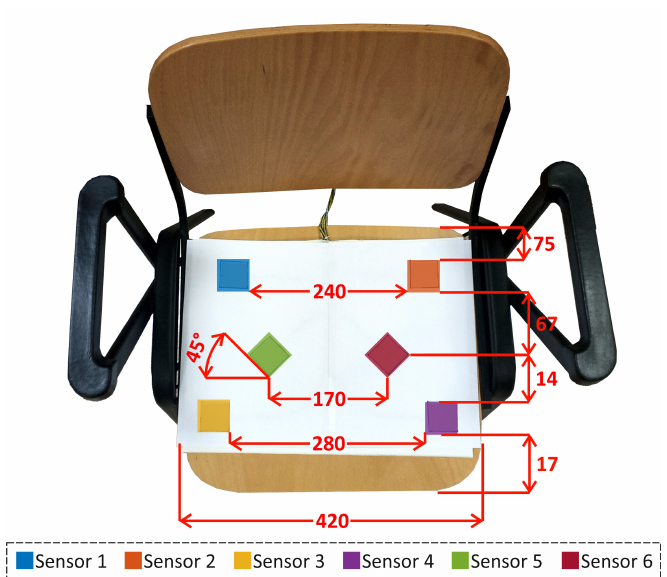
Figure 1. Measuring device installed on a chair. The device has bilateral symmetry. All linear dimensions in